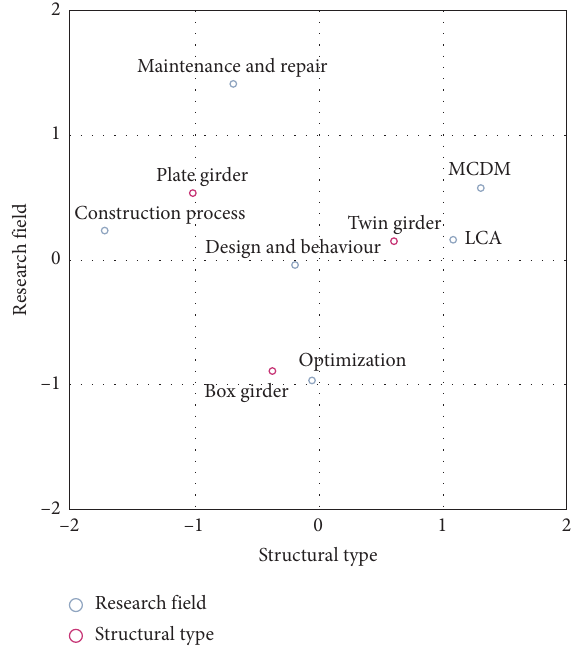
Figure 6: Simple correspondence analysis for research field and structural